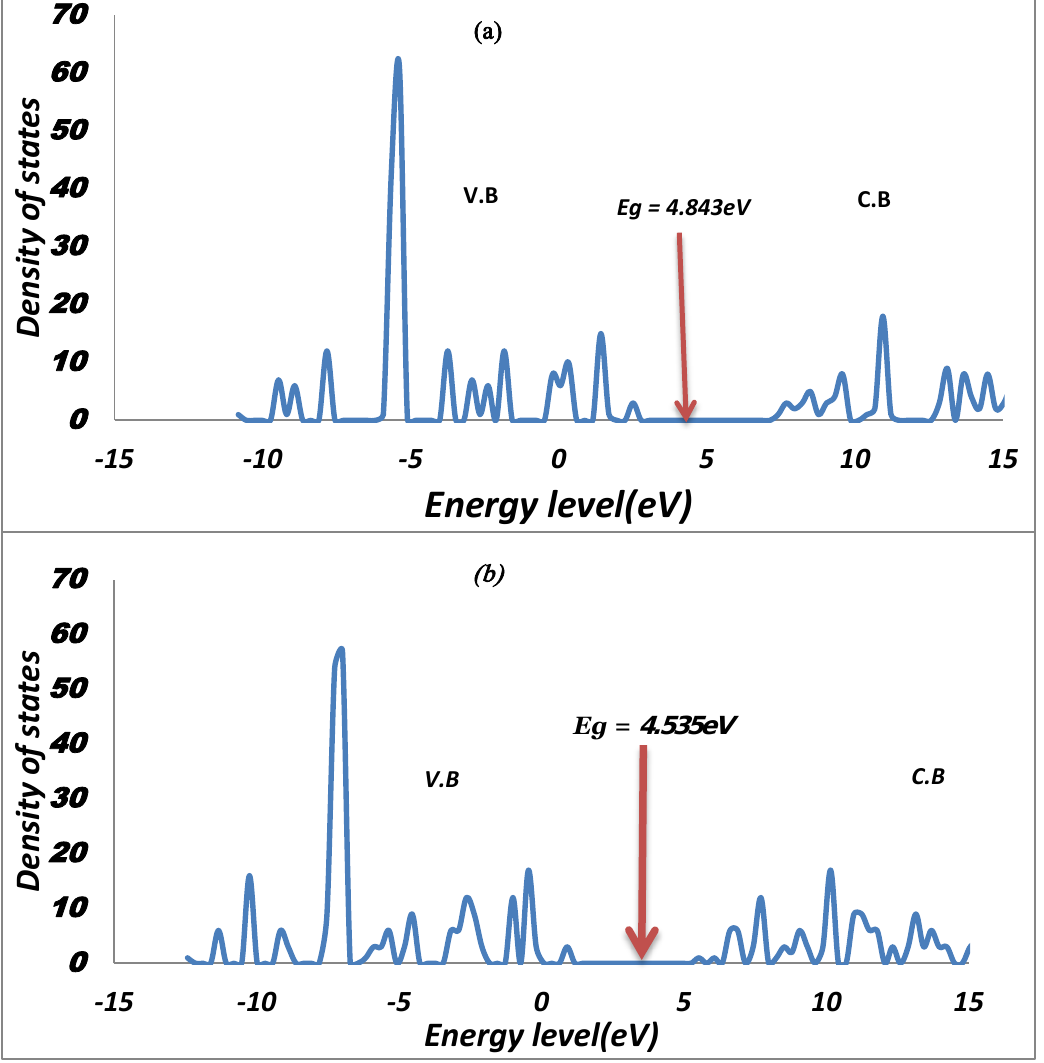
Fig. 8: Density of states of (a) 54 and (b) 64 atoms of core part of AlAs crystals. The energy gap is shown between the conduction and valence